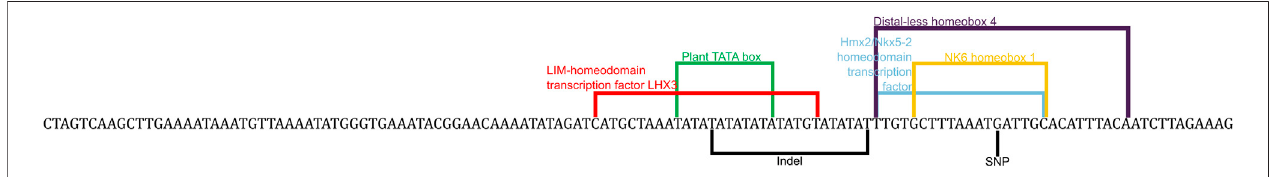
Frontiers in Toxicology |